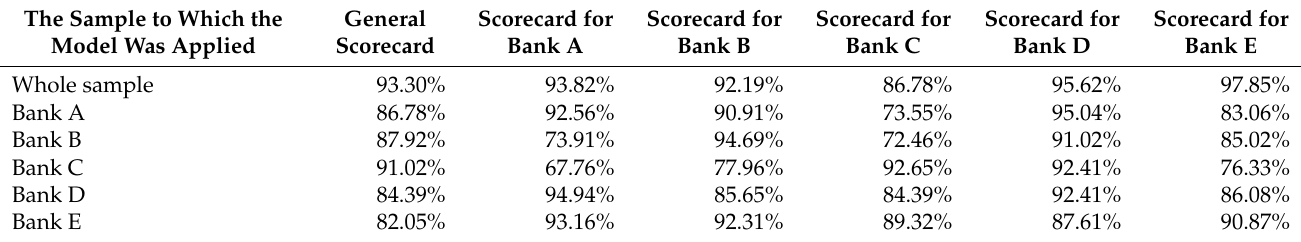
Table 14. Summary of the second efficiency level of the developed scoring models to evaluate customers in other banks.